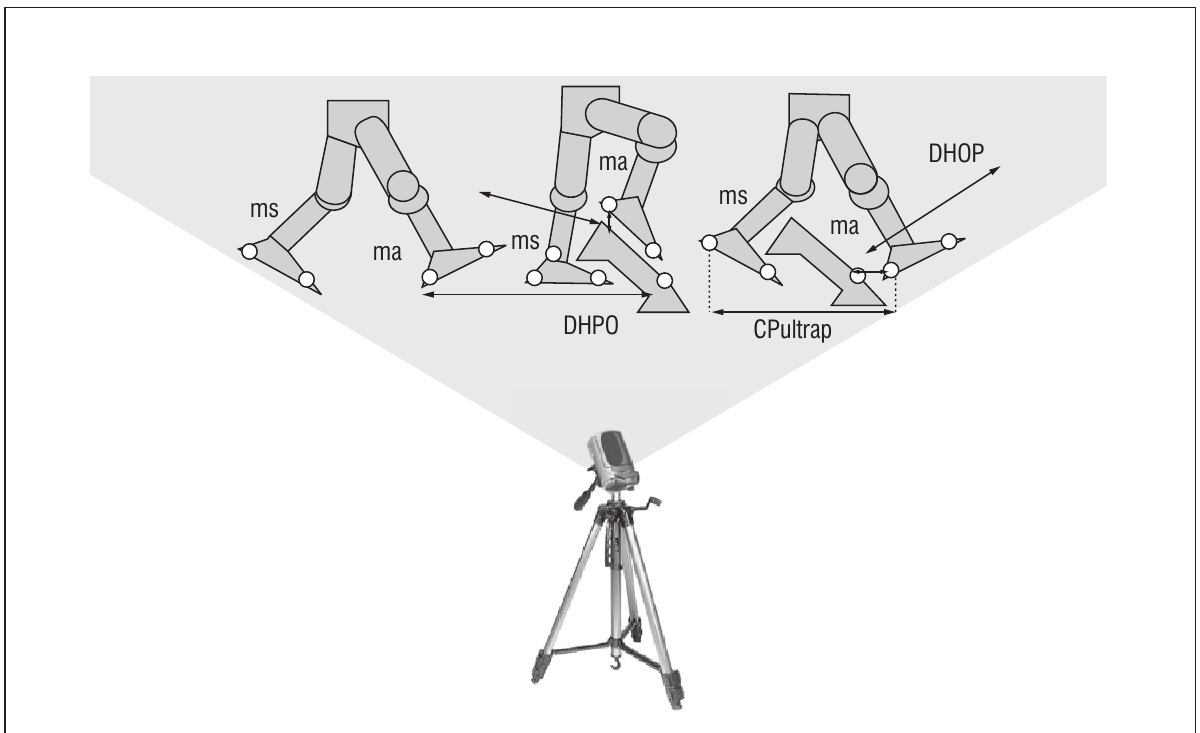
Figura 1 - Esquema representativo da situação experimental e das variáveis dependentes nas condições com obstáculo, distância horizontal pé/obstáculo (DHPO), distância horizontal obstáculo/pé (DHOP), do membro de abordagem (ma) e do membro de suporte (ms), e comprimento do passo de ultrapassagem (CPultrap) Fonte: Dados da